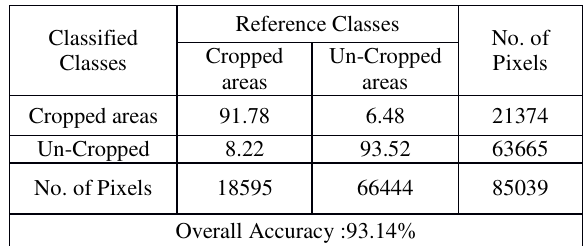
Figure 2b LISS III FCC showing cropped and uncropped area (22 nd January